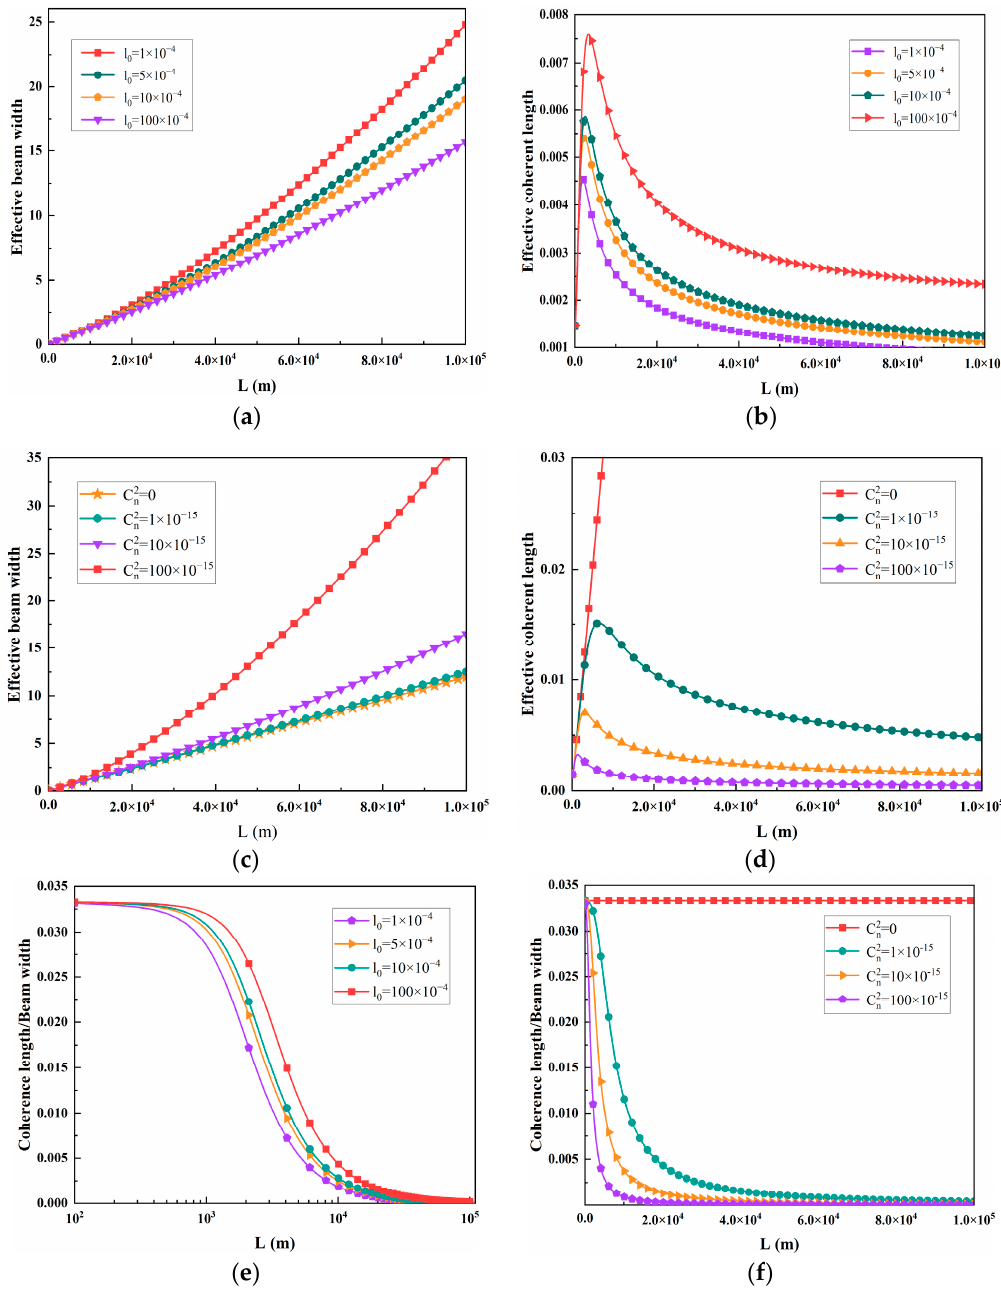
Figure 8. The impact of the atmospheric refractive index structure constant and inner scale on the beam width and coherence length and their ratio in turbulent conditions. ( a , b , e ) λ = 532 nm; = 3 cm; σ h = 1